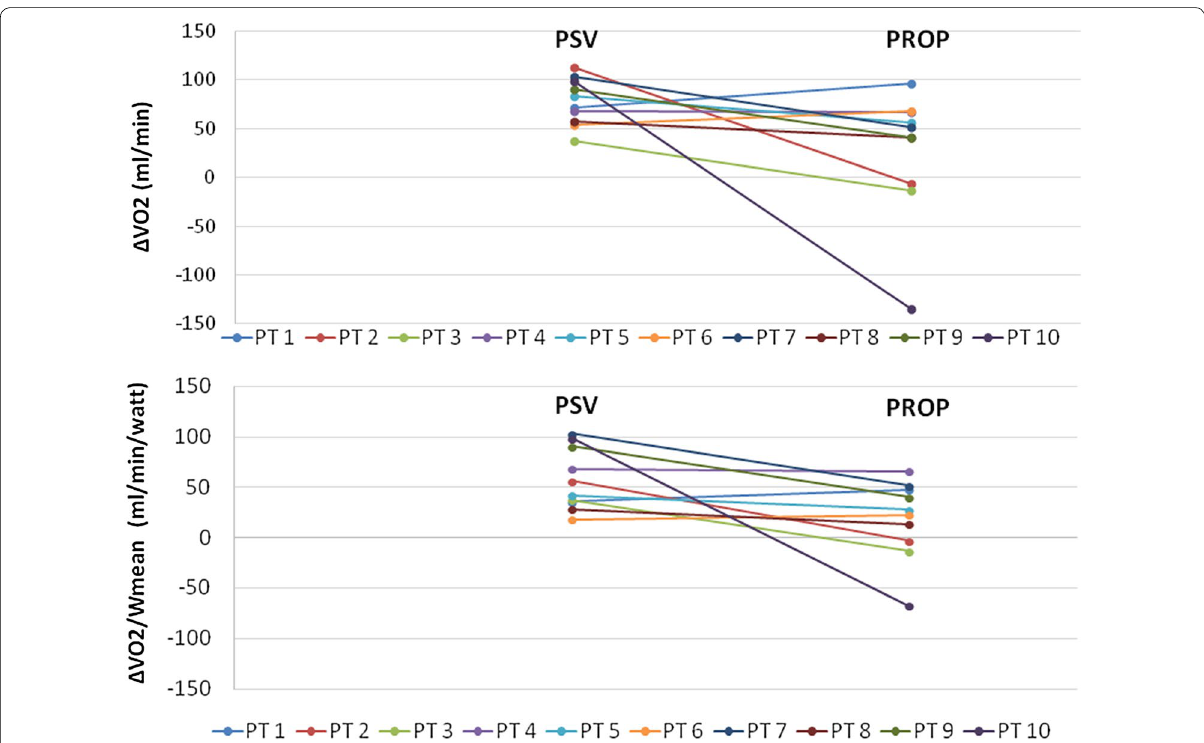
Fig. 3 Changes in oxygen consumption (ΔVO 2 ) and ΔVO 2 /Wmean before and after exercise between the modes tested. ΔVO 2 ; difference in VO 2 between the start and the end of exercise in absolute values. PROP proportional ventilation, PSV pressure support